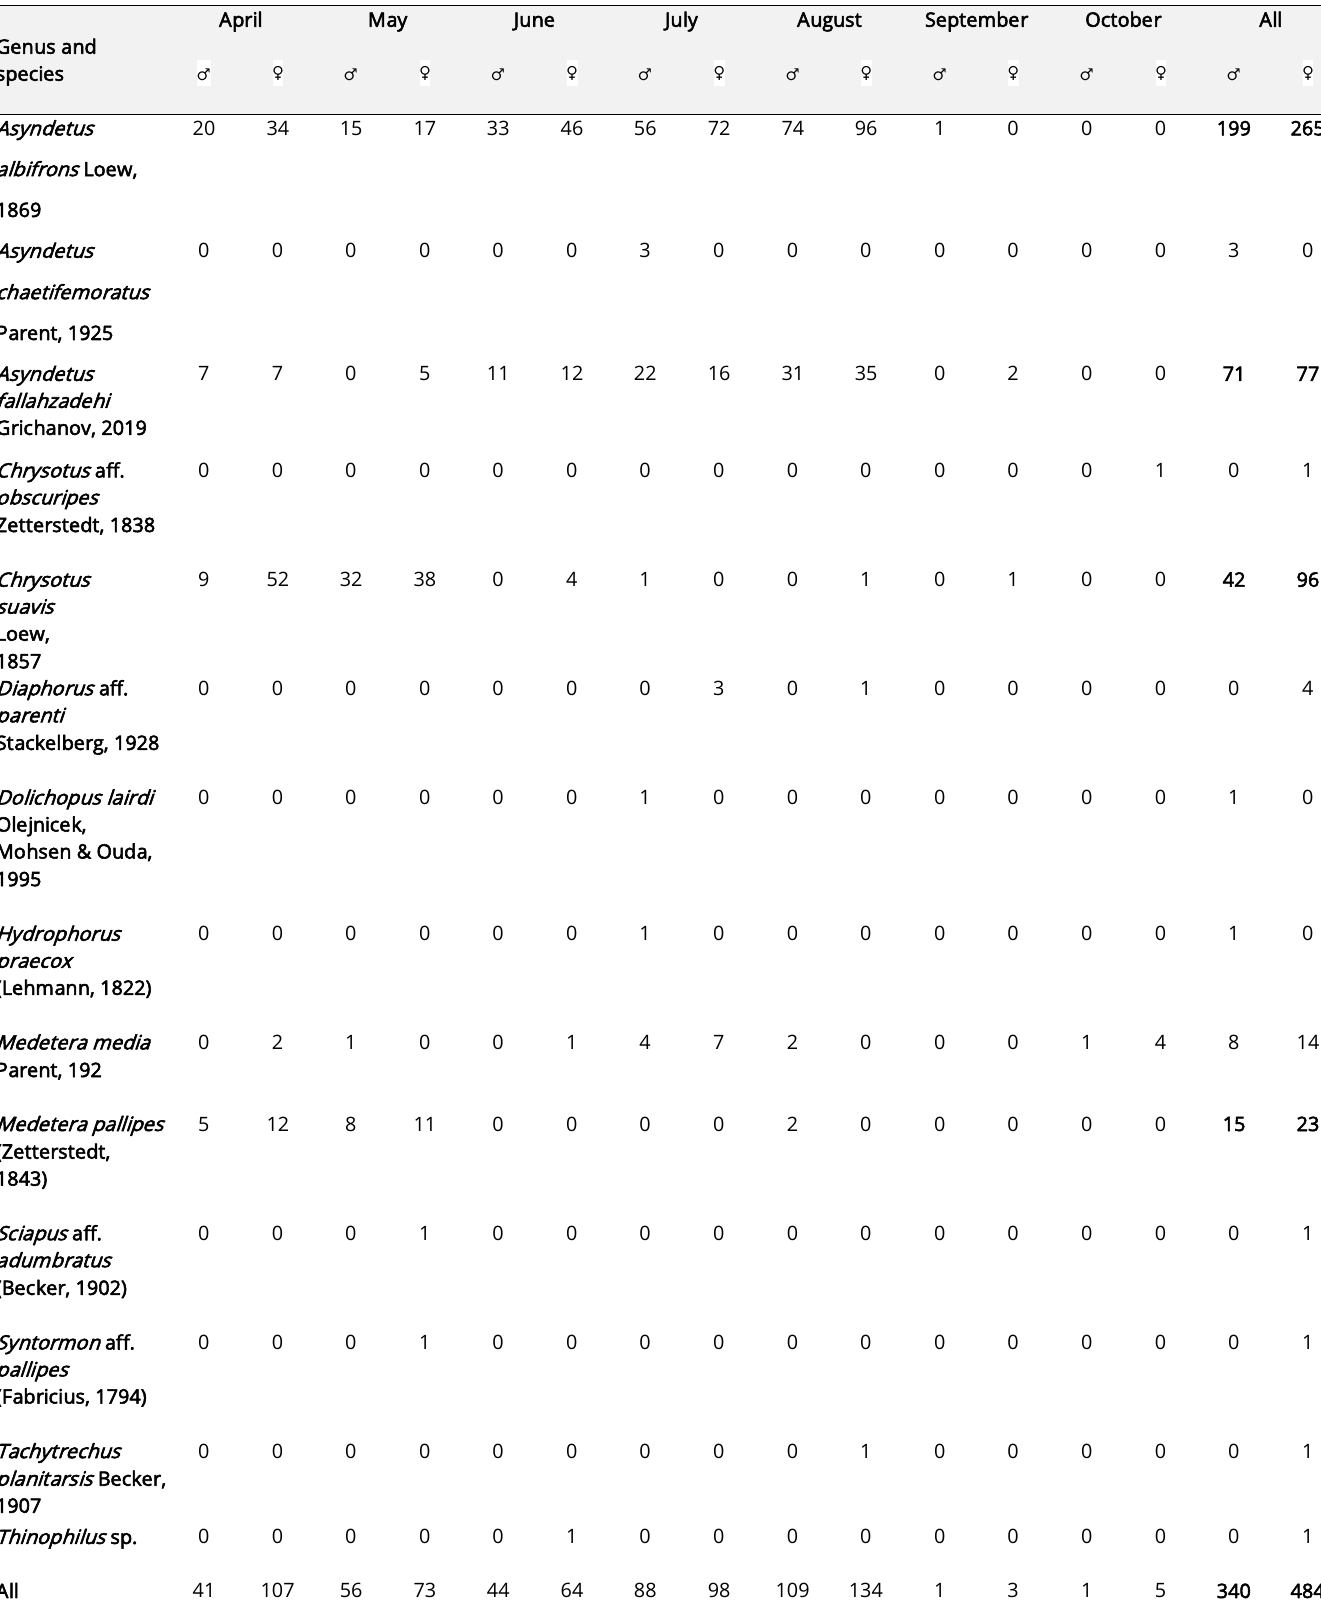
Table 1. Number of males and females of collected long-legged fly species (Diptera, Brachycera, Dolichopodidae) in Fars,